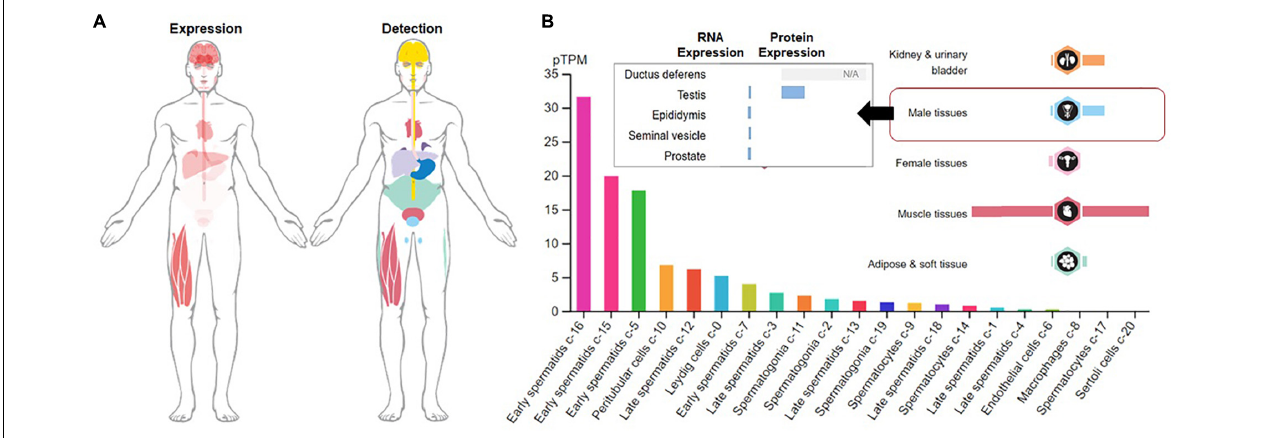
FIGURE 1 | Expression and detection of Fibronectin type III domain containing 5 (FNDC5). (A) Global expression and detection of FNDC5 RNA/protein; (B) FNDC5 RNA (normalized expression) and protein expression in overall male reproductive tissues and specific testicular